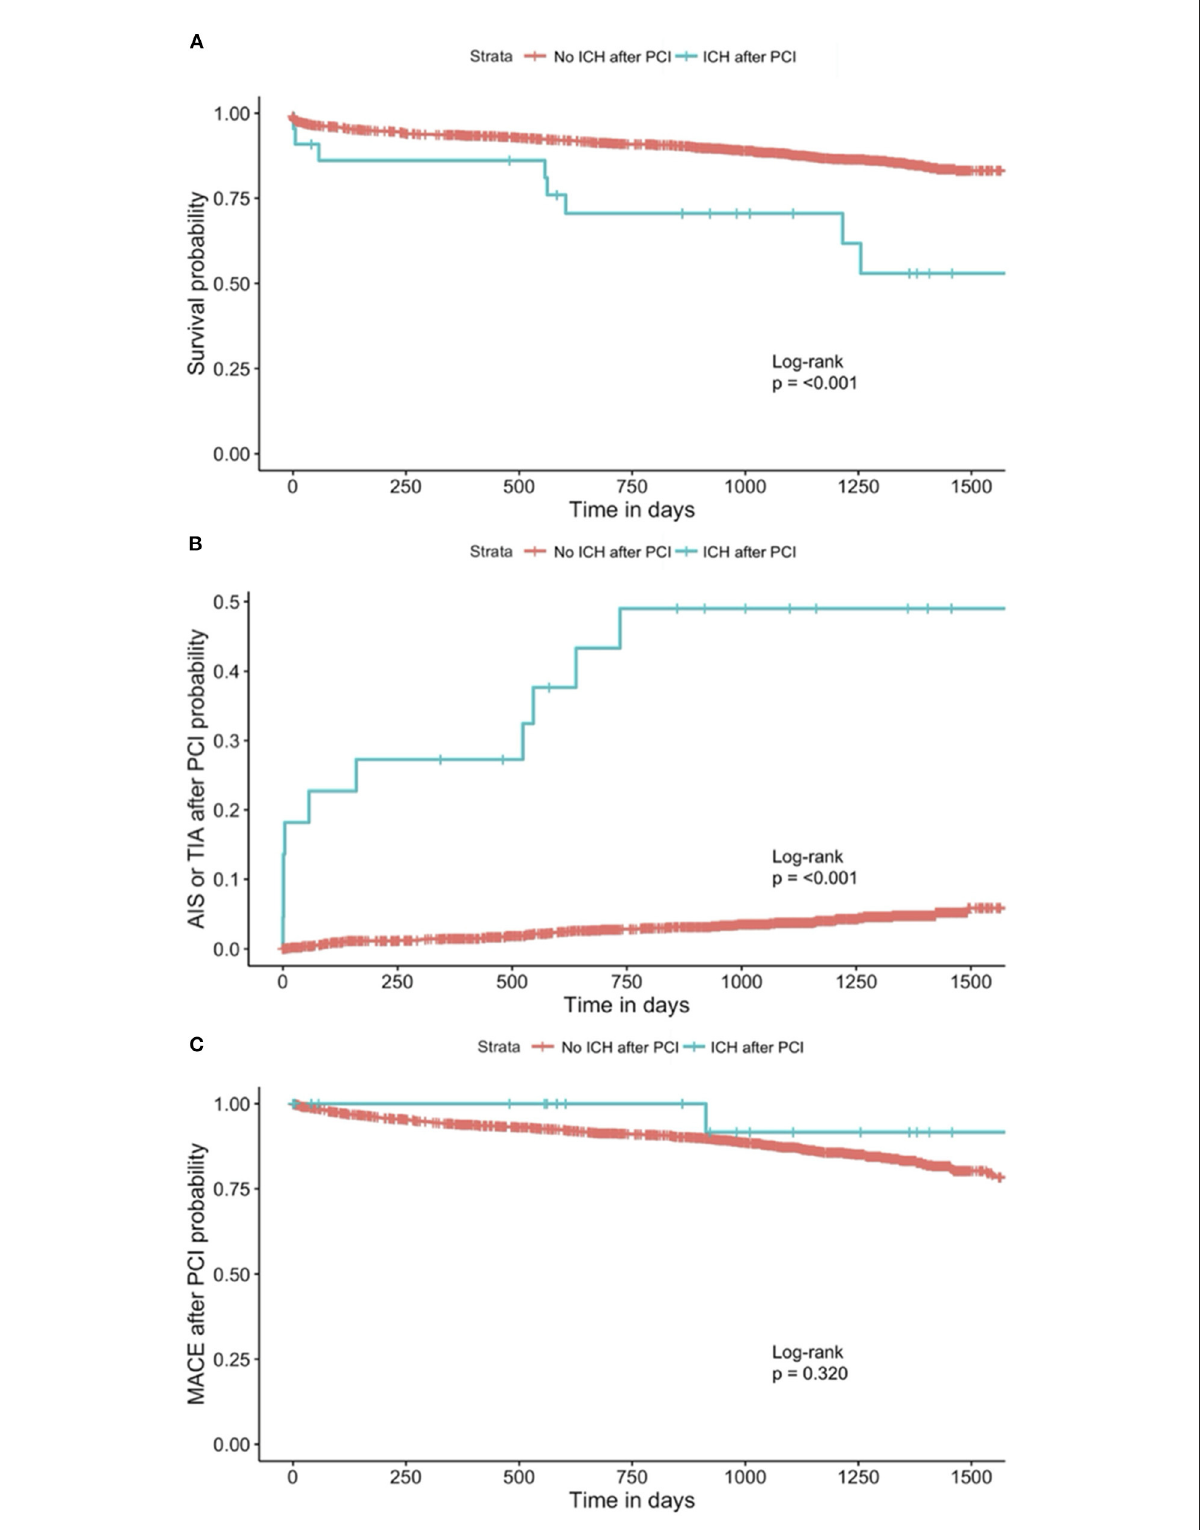
FIGURE1 Kaplan-Meier curve for (A) all-cause mortality 1,2 , (B) AIS or TIA after PCI 1,3 , and (C) MACE after PCI 1 , stratified by patients with and without ICH after PCI. 1 The one patient who had missing data on the indication of the current PCI was excluded from the analysis. 2 The seven patients who had missing data on all-cause mortality were excluded from the analysis. 3 The nine patients who had missing data on AIS or TIA after PCI were excluded from the analysis. AIS, acute ischemic stroke; TIA, transient ischemic attack; MACE, major adverse cardiovascular events; PCI, percutaneous coronary intervention; ICH, intracerebral